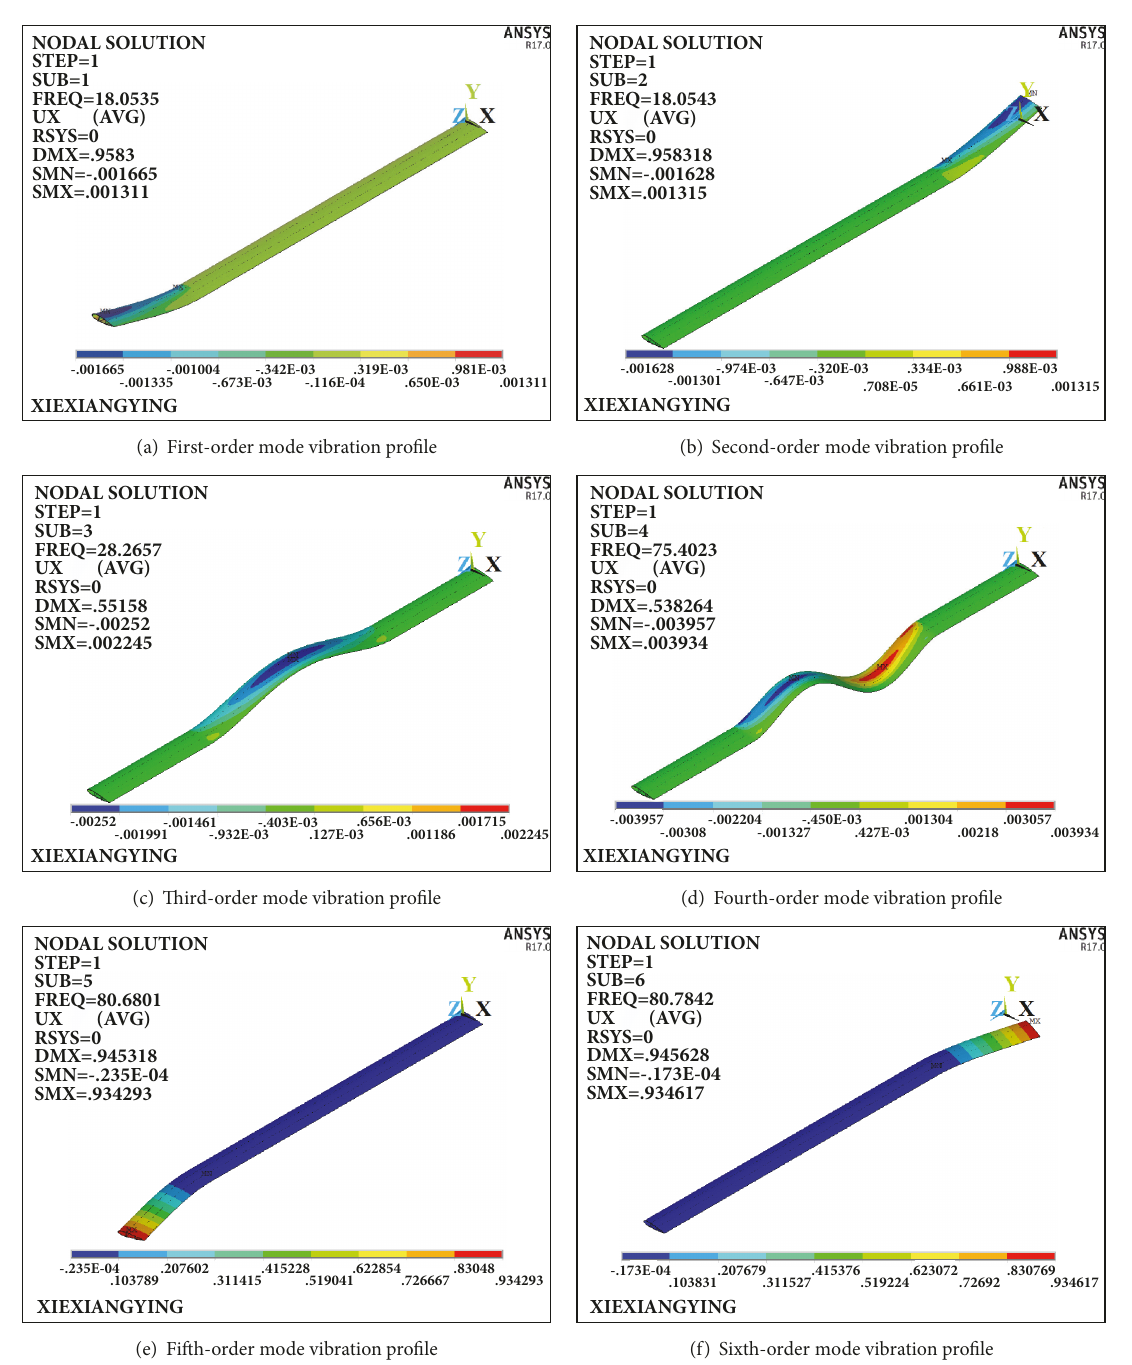
Figure 15: The first six-order mode vibration profile of main